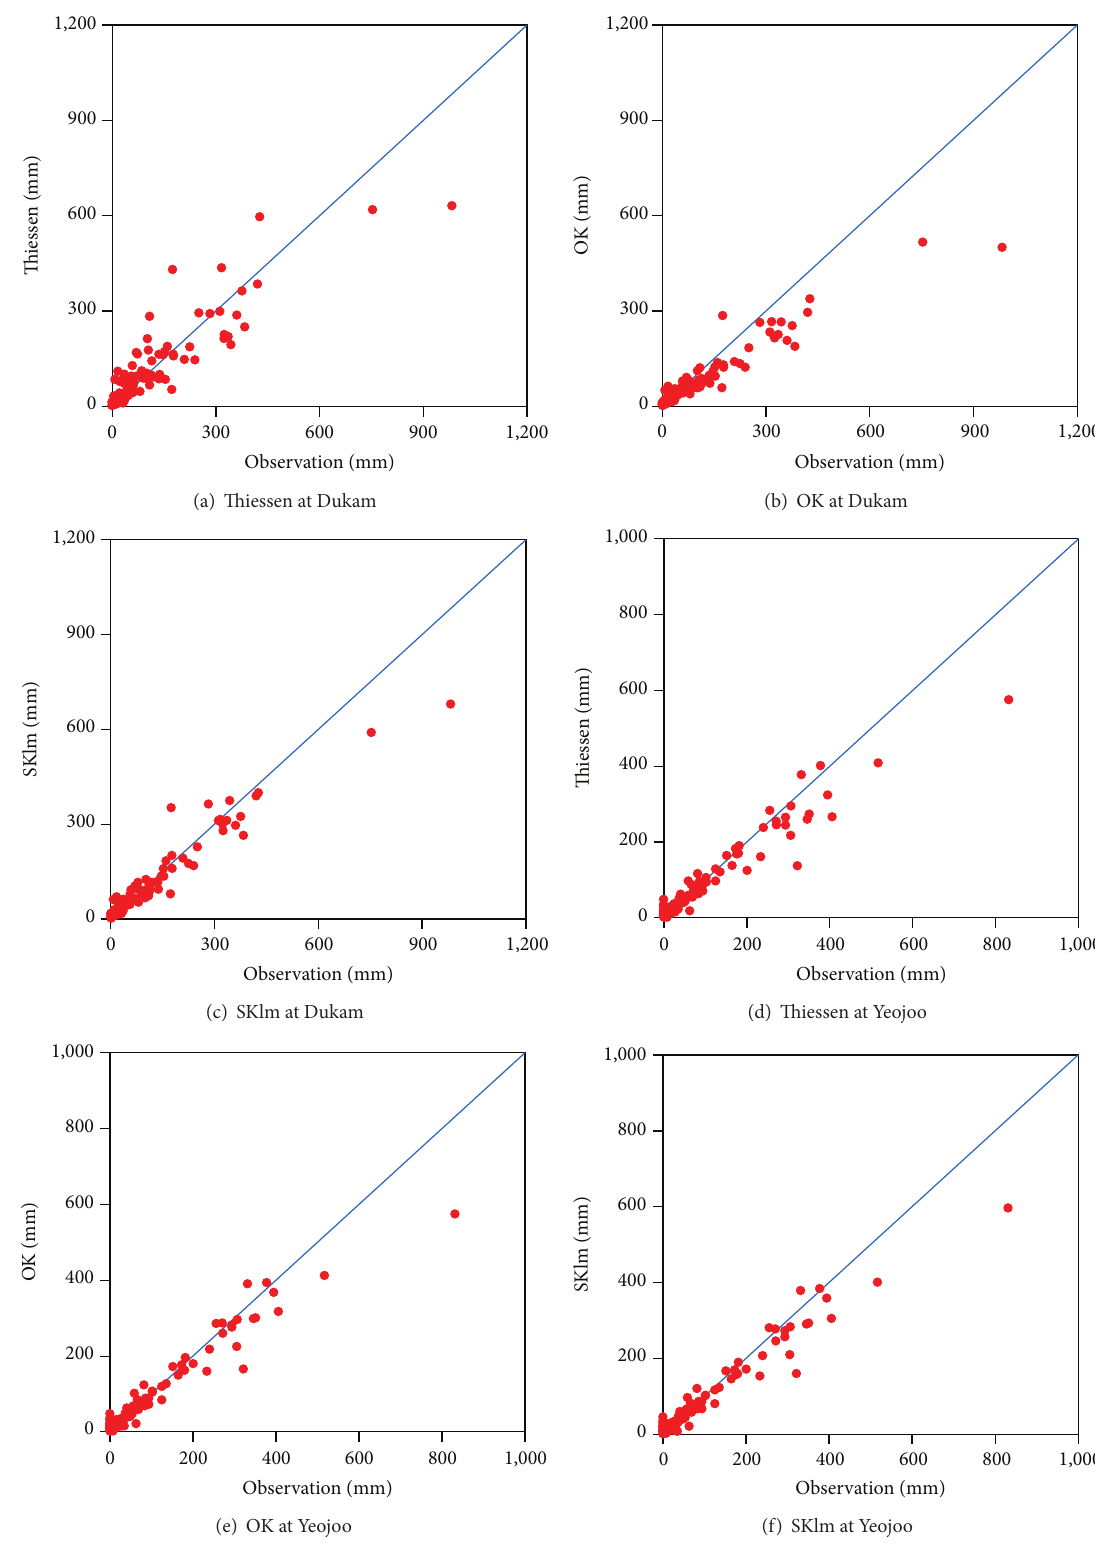
Figure 8: Examination results by technique dependent on elevation